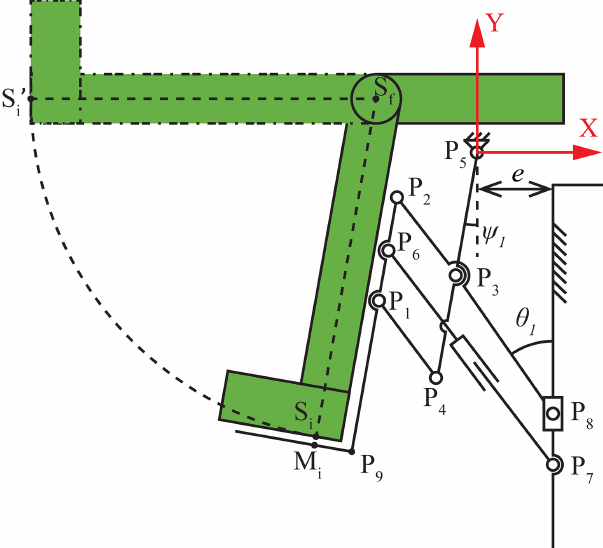
Figure 12. Schematic diagram of human–machine coupling motion of the leg